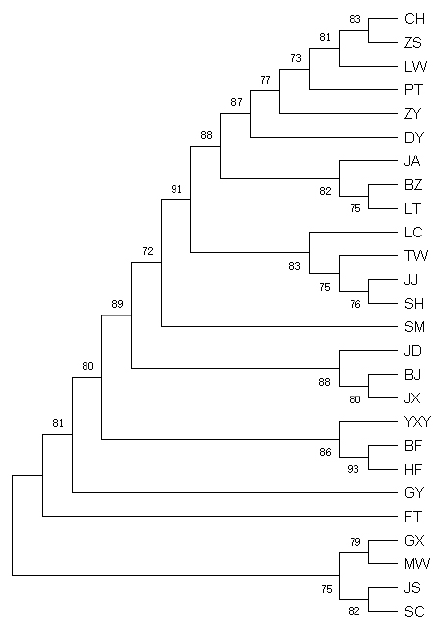
Figure 4. Phylogenetic tree based on mtDNA control region sequences for the 26 duck populations.